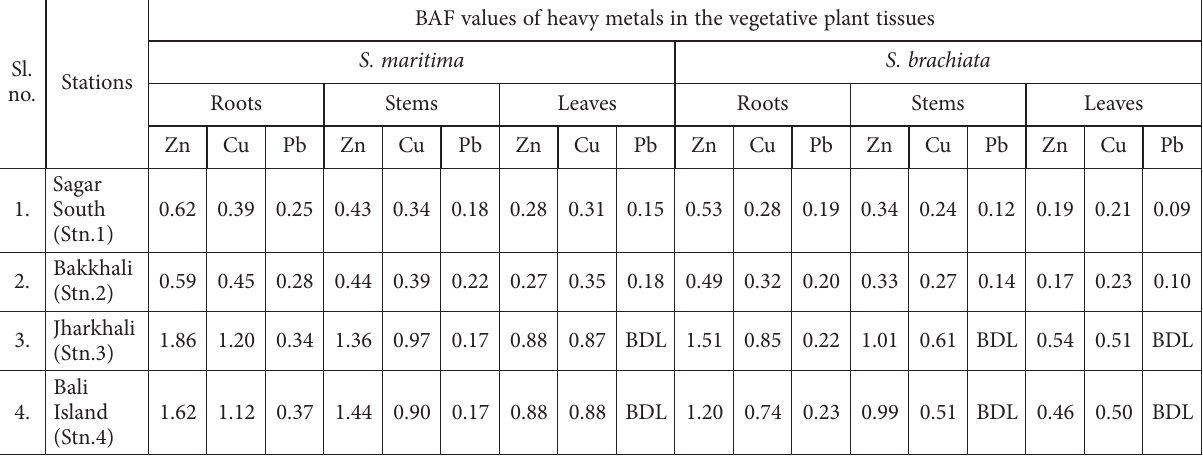
Table 1. Bioaccumulation factor (BAF) values of heavy metals in the vegetative tissues of S. maritima and S. brachiata